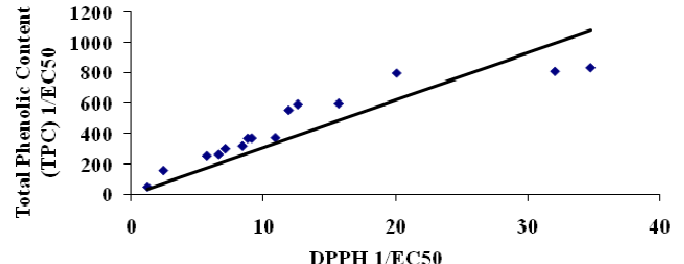
Figure 1. Correlation between Total Phenolic Content and DPPH assay (antioxidant). Correlation =